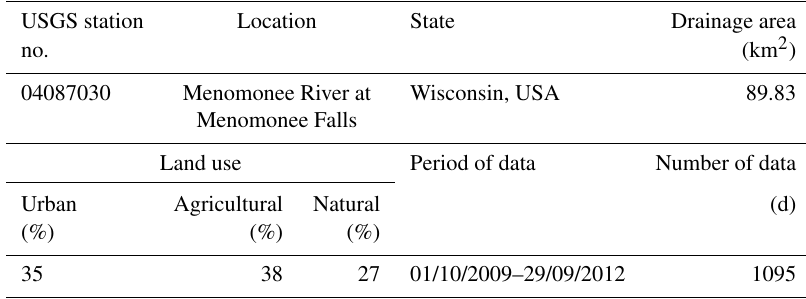
Table 3. Characteristics of the study catchments and calibration